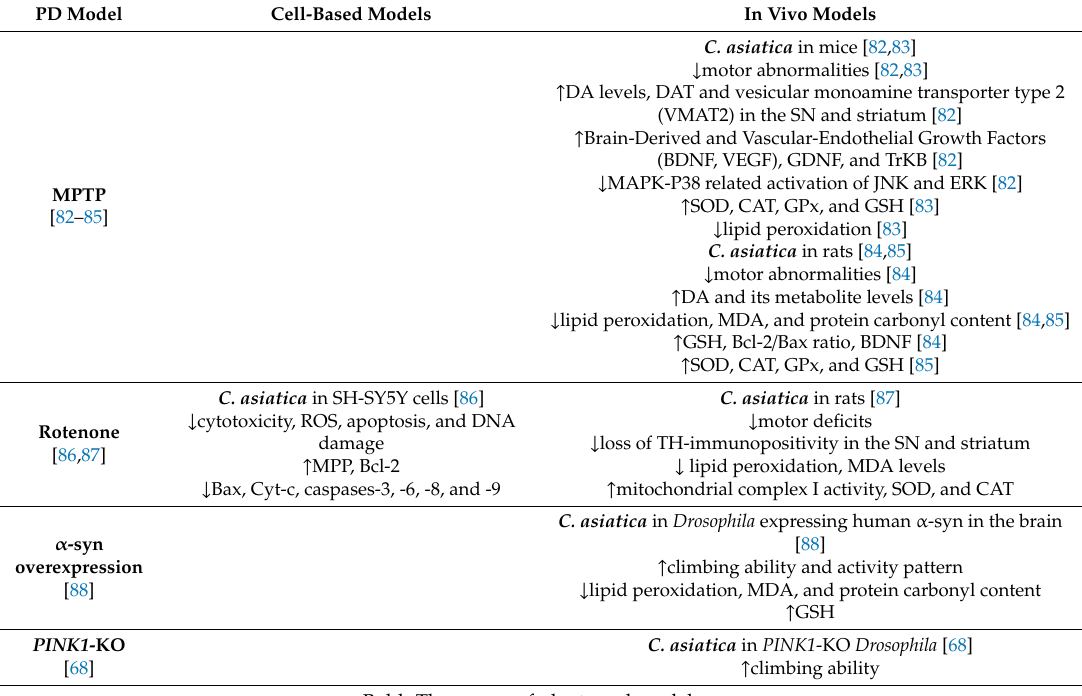
Table 4. Neuroprotective e ff ects of Centella asiatica in PD